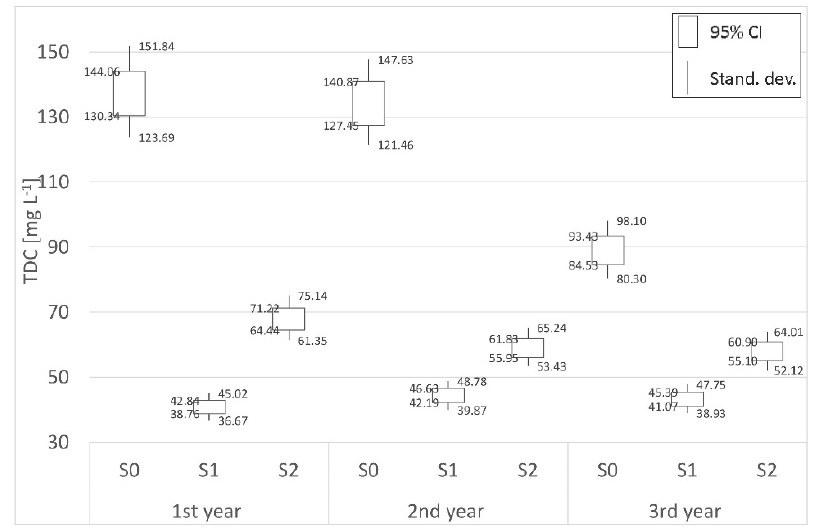
Figure 2. The concentrations of TDC in groundwater under peatland soils ( □− 95% confidence inter- val, │ - standard deviation).